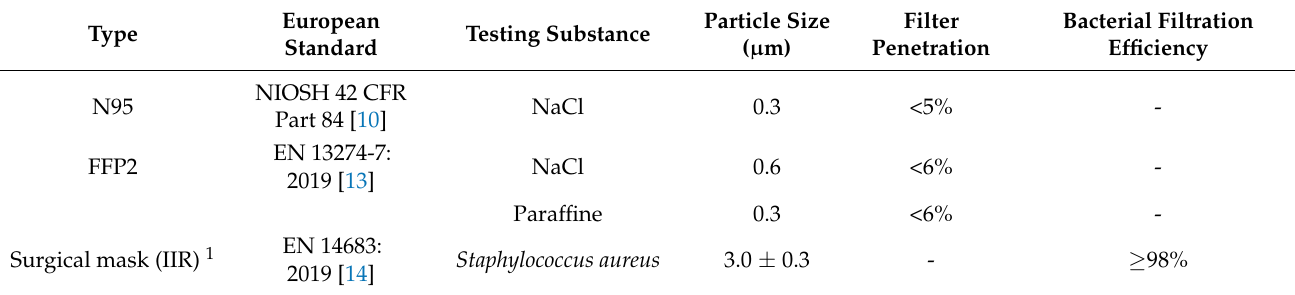
Table 1. Test conditions and performance standards for respirators and surgical masks in Europe and the US.